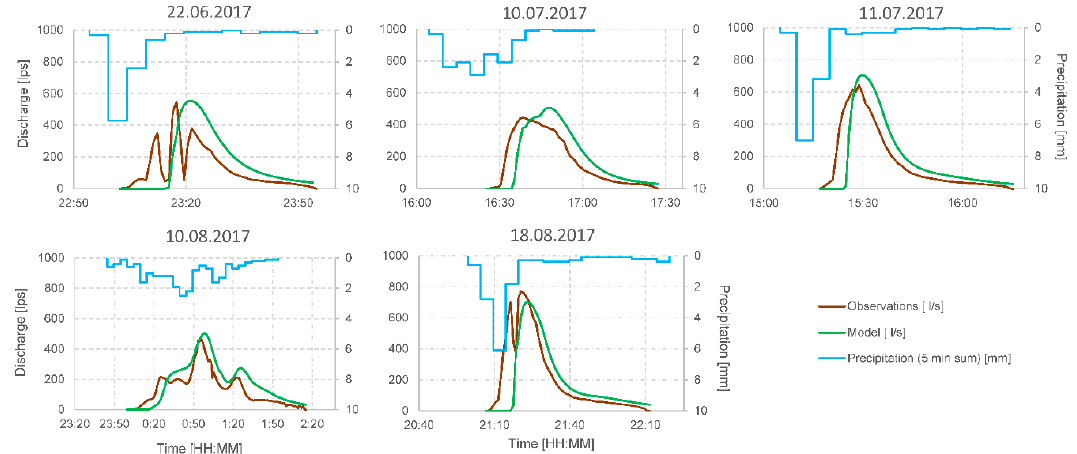
Figure 4. Results of event-based calibration.